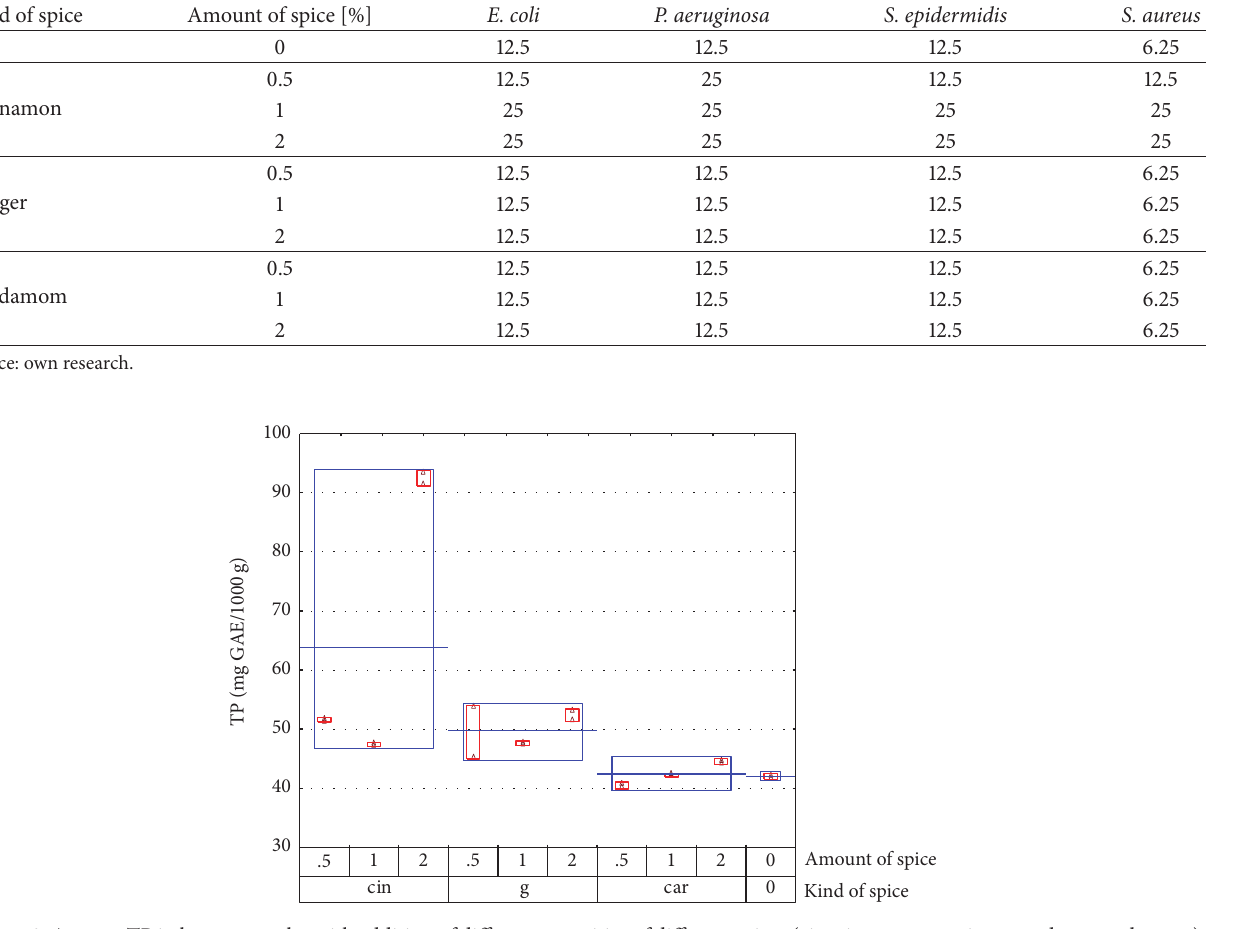
Figure 2: Average TP in honey samples with addition of different quantities of different spices (cin: cinnamon, g: ginger, and car: cardamom). Source: own research.